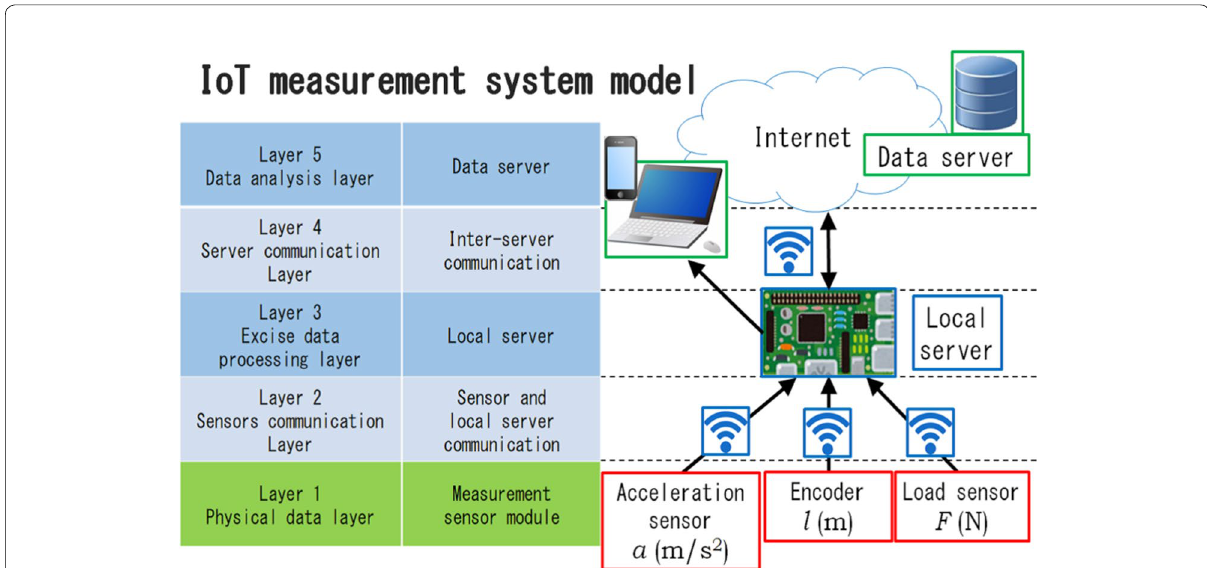
Fig. 2 IoT measurement system model (IMSM)—to construct the optimal system more simply, classification is performed in a layer-based approach using the data flow from the sensor’s